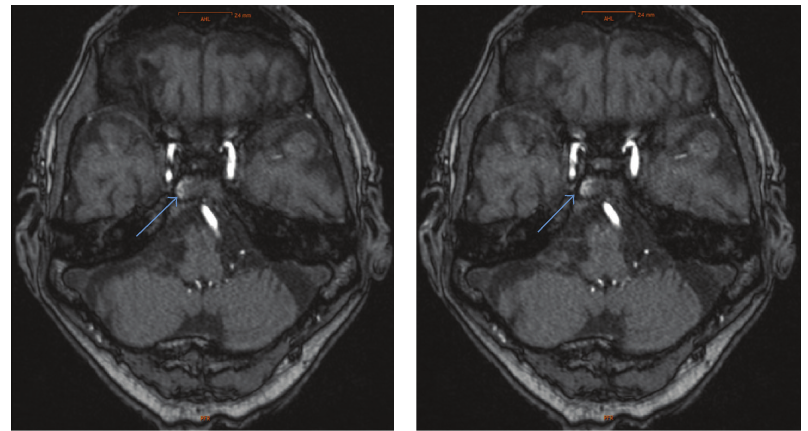
Figure 1: MRI axial images with contrast enhancement of the right cavernous sinus.